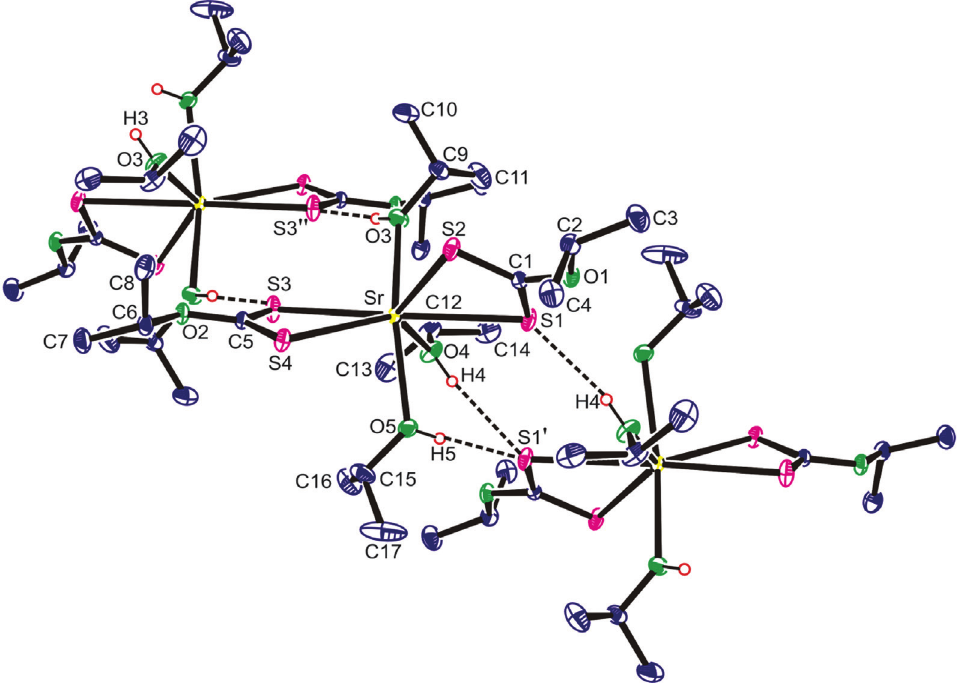
Figure 2 The asymmetric unit of 2 showing the labeling scheme used. Thermal ellipsoids are at the 30% probability level. H(3) of the asymmetric unit [bonded to O(3)] is unlabeled. Only the O-H hydrogens have been included for clarity. Symmetry operations: ′- x , 1- y , 1- z ; ″- x , 2- y , - z .